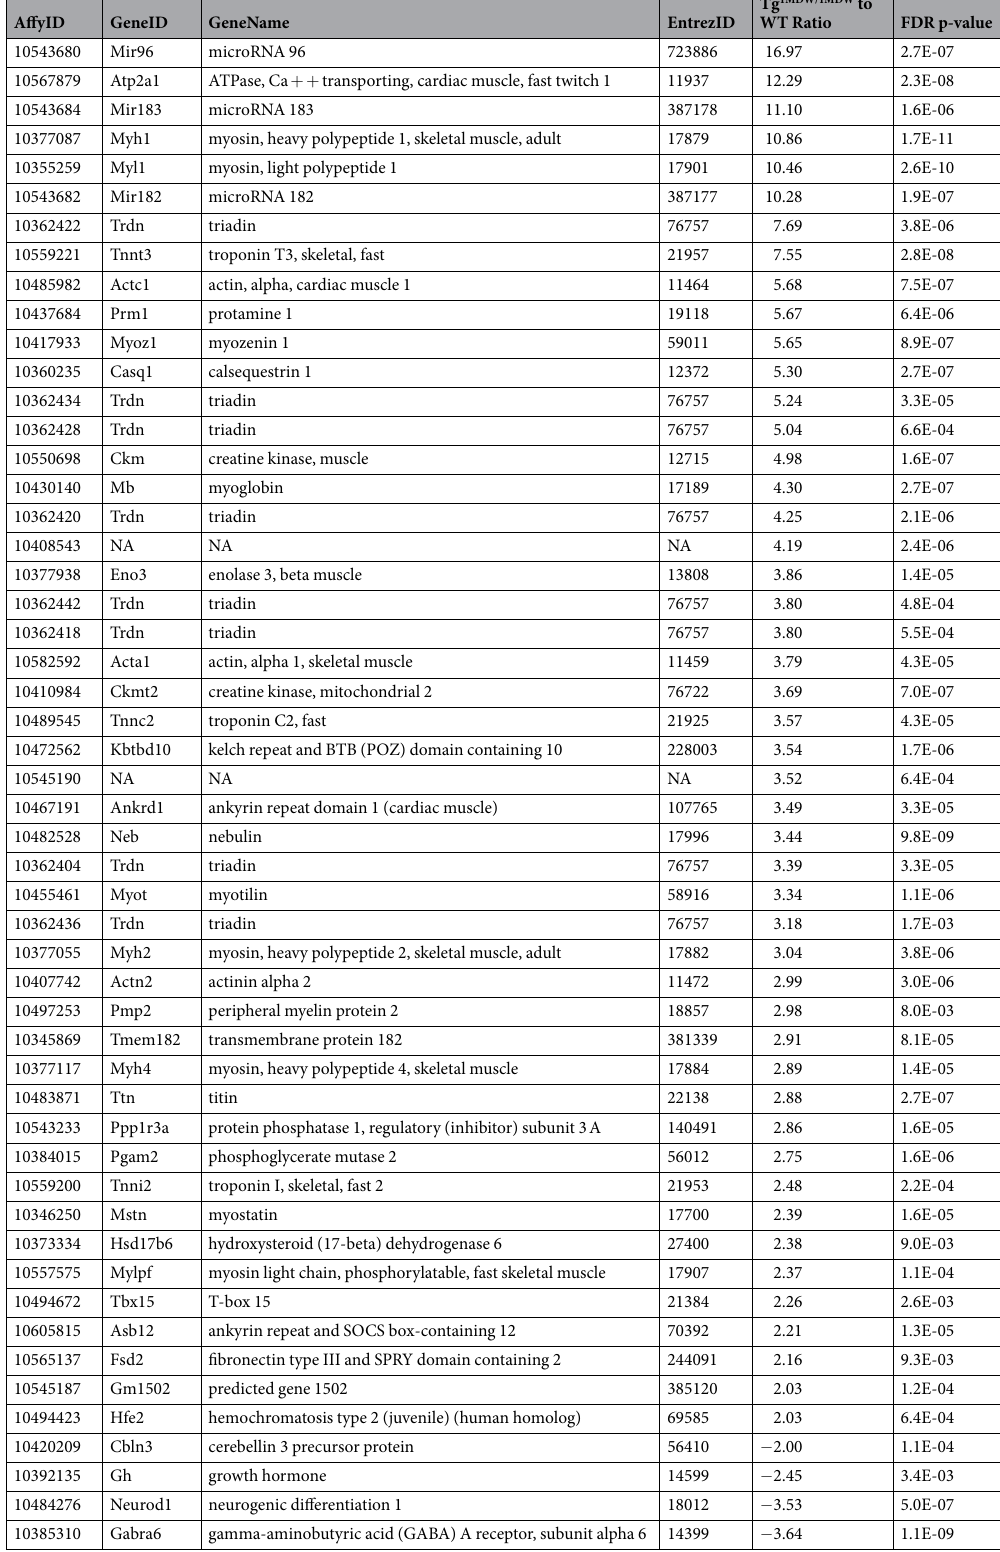
Table 3. List of 52 significantly changed Tg 1MDW/1MDW changed Affymetix probesets in the P18-cochlea. From a total of 28,188 annotated probesets using the Limma Package and MicroArraysRUS Gui interface to R and Bioconductor microarray analysis